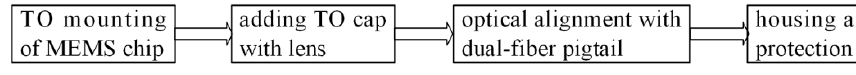
Figure 5. Schematic diagram of the assembling procedures.